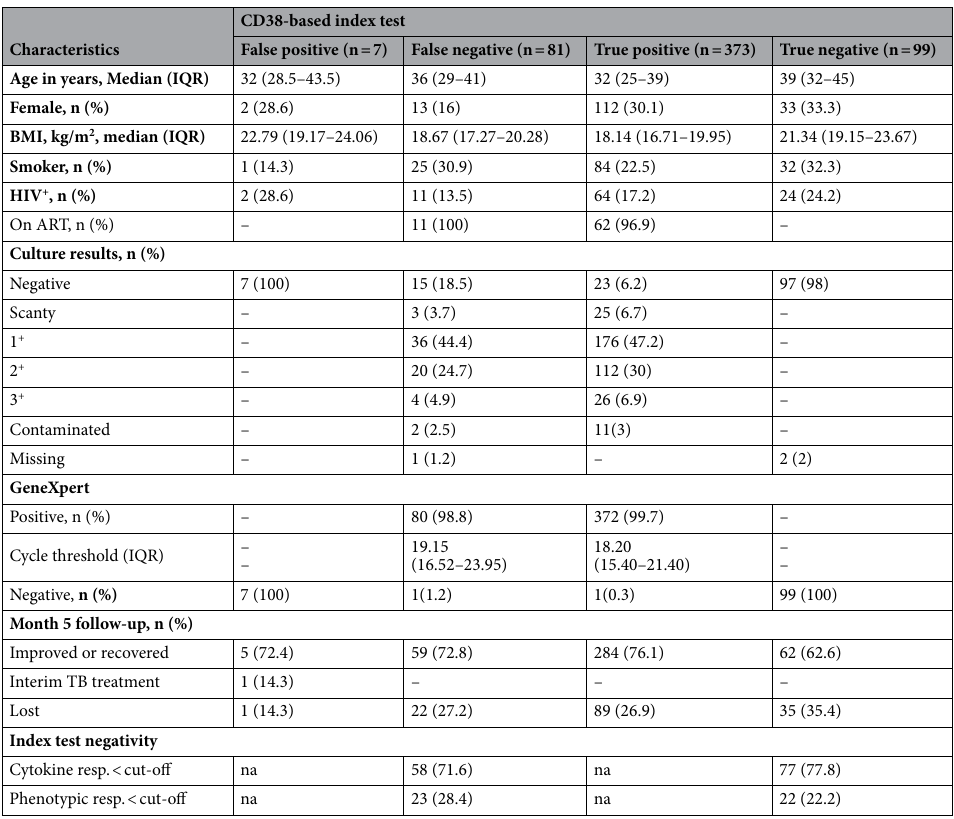
Table 2. Patients and assay characteristics at enrolment stratified by CD38-based index test results. BMI-Body mass index. Scanty: < 20 colonies, 1 + : 20 to 200 colonies, 2 + : > 200 discrete colonies, 3 + : > 200 confluent colonies. MTB: M. tuberculosis , RIF: Rifampicin, ART: Antiretroviral therapy; 1 Symptoms/condition at enrolment, na: not applicable, nd: no